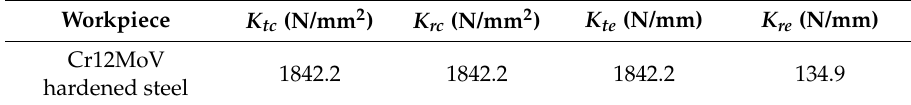
Table 3. The cutting force coefficients.